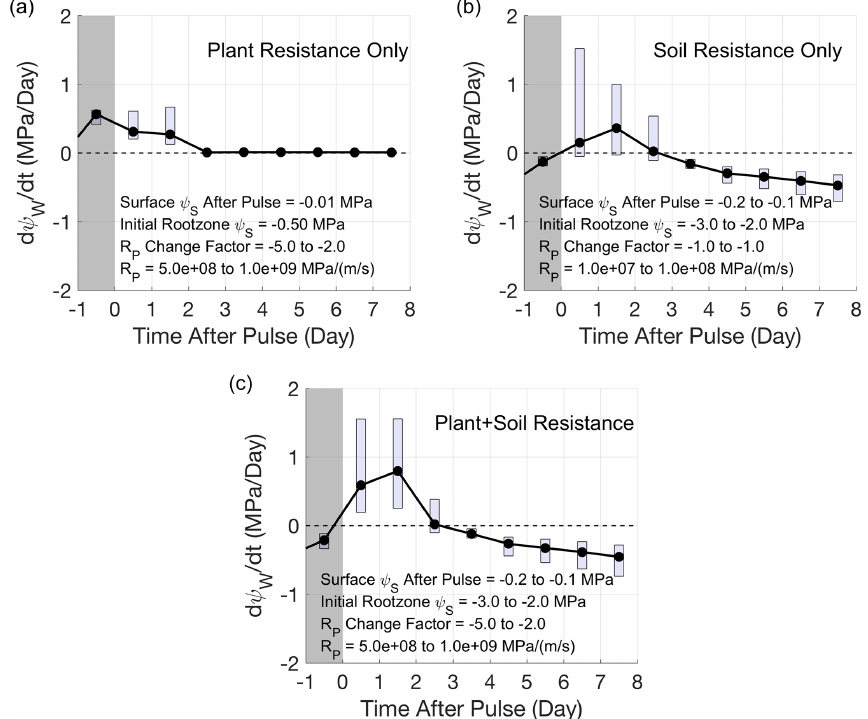
Figure 7. SPAC model simulations of determined sufficient conditions driving slow rehydration (see text and SI) for semi-arid grass and shrub species. Rate of change in predawn water potential ( ψ w ) of all plant water stores on a given day following a pulse where d ψ w /d t > 0 indicates rehydration. Same format and conventions as Fig. 3. Parameter bounds determined to drive each slow rehydration scenario are shown in each panel. (a) Plant limitation only where plant resistance ( R p ) is initially high and decreases. (b) Soil limitation only where root zone soil moisture is initially dry and pulses are small to moderate, causing slow infiltration. (c) Both plant and soil limitations superposed from (a) and (b) . Parameter ranges common amongst all simulations: rooting depth = 0.3 to 0.7m, vapor pressure deficit (VPD) = 1 to 5kPa, wind = 1 to 8m/s, capacitance = 10 − 6 to 10 − 5 m/MPa, R S impairment factor =− 10 to − 1. See SI for more information on the SPAC model and